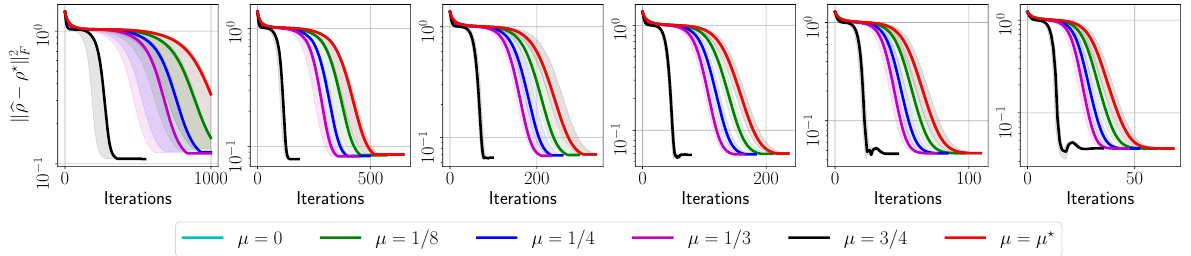
Figure A18. Target error list plots for reconstructing Hadamard ( 8 ) circuit using synthetic measure- ments from IBM’s quantum